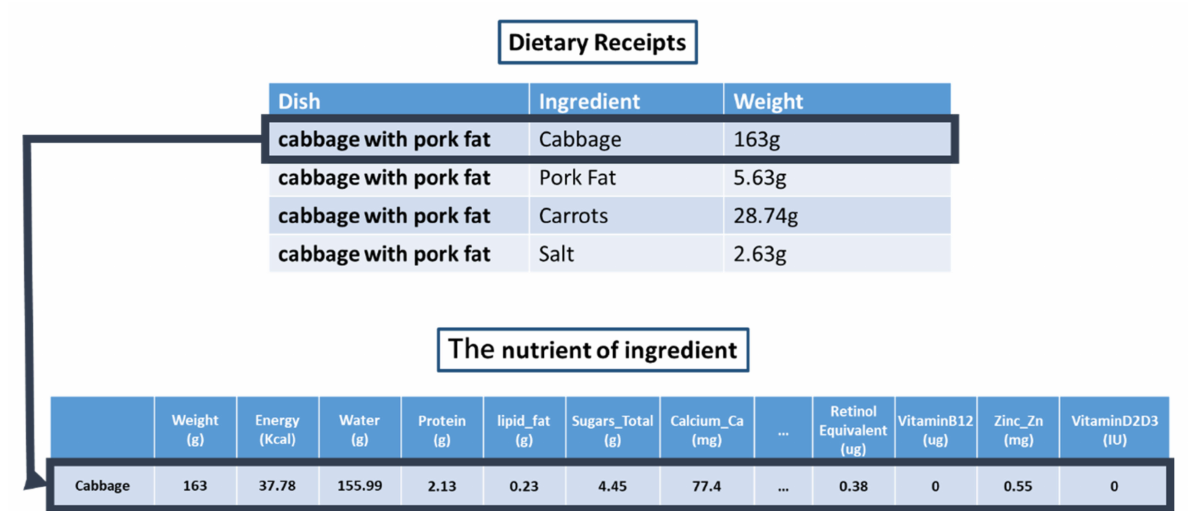
Figure 2. Nutrition Survey—Dietary Information Conversion